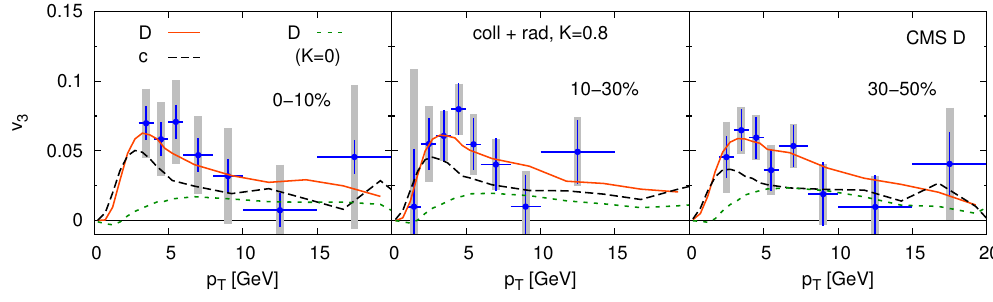
Figure 4. Same as Fig. 3 but for the triangular flow.